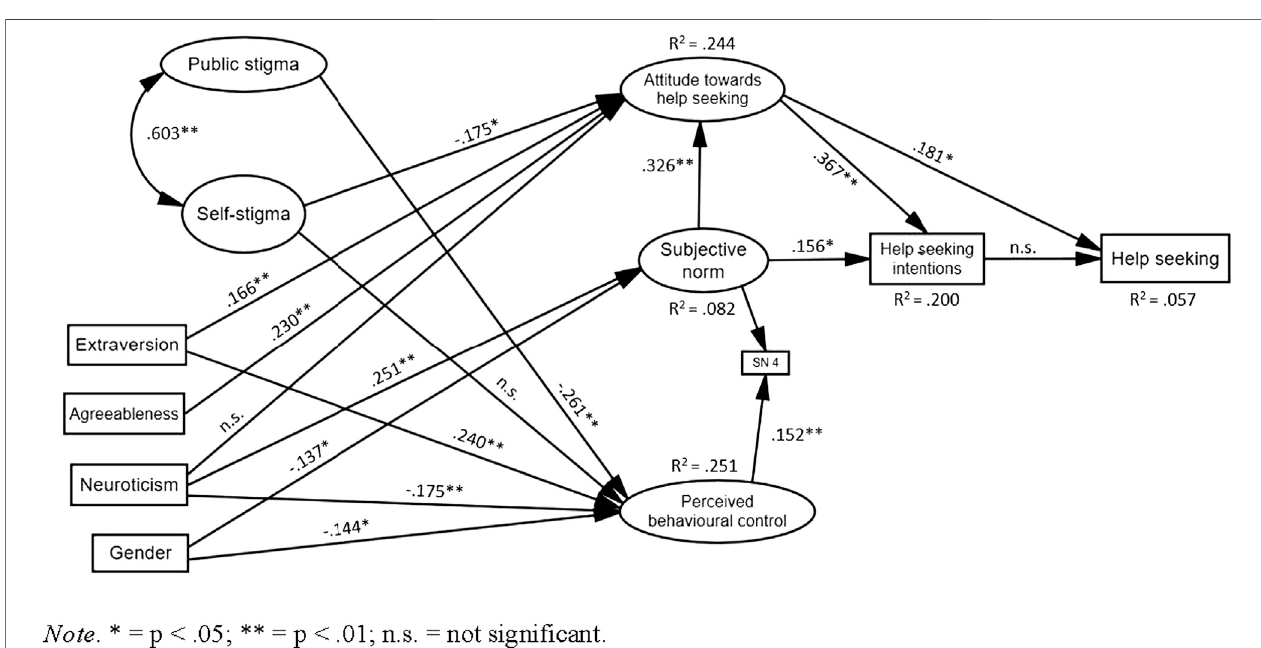
FIGURE 5 | Standardised regression weights and squared multiple correlations for fi nal model.